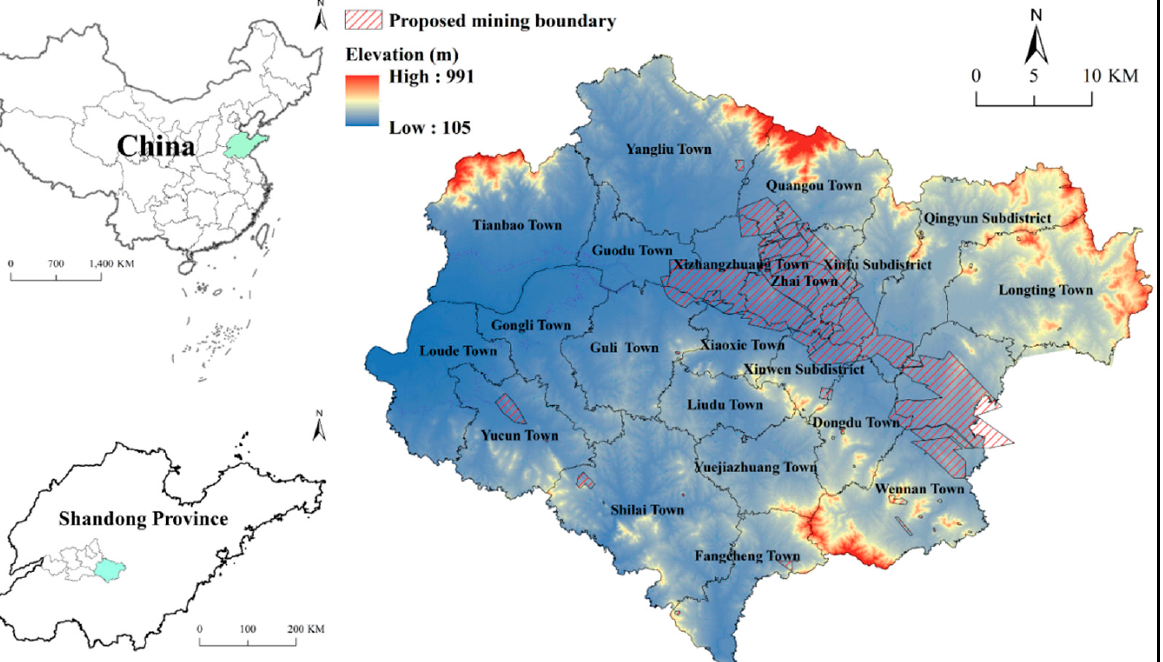
Table 1. Data categories and sources. Data Category